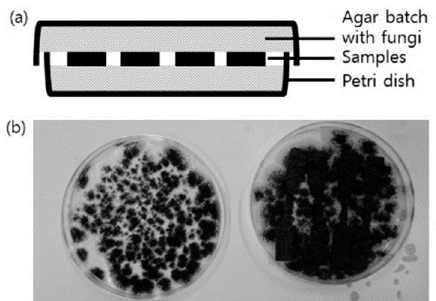
Figure 1. ( a ) The scheme of experimental settings for degradation test; ( b ) The picture of the fungi Aspergillus awamori grown as a batch and the placement of samples for the degradation test.